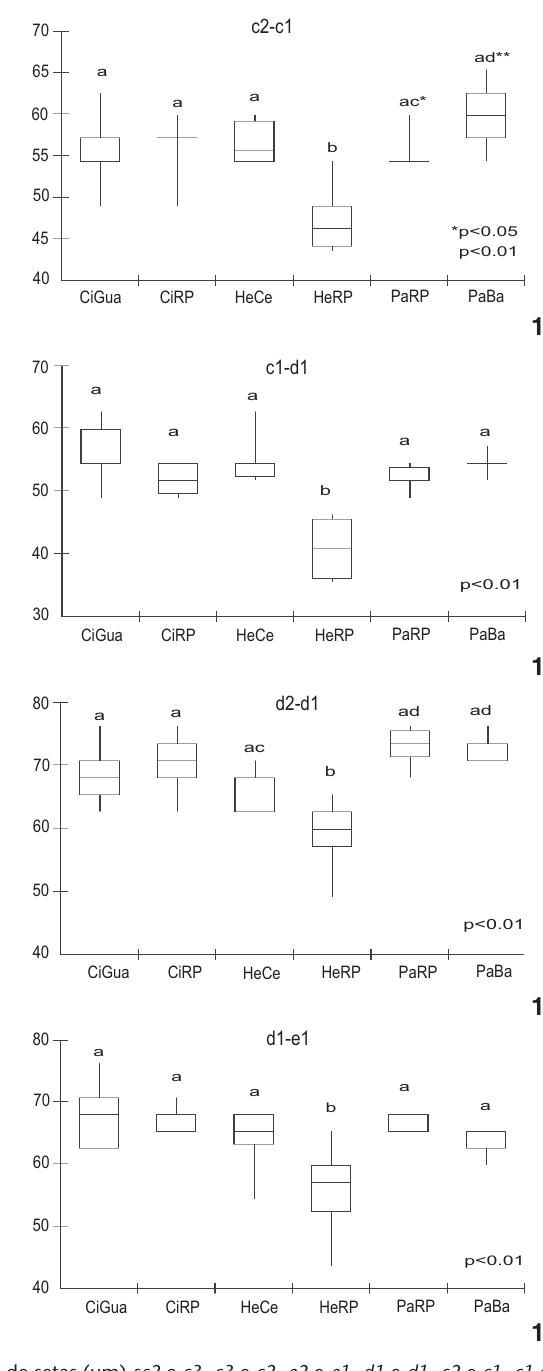
Figuras 9-16. Distribuição das distâncias entre os elementos dos pares de setas (µm) sc2 e c3 , c3 e c2 , e2 e e1 , d1 e d1 , c2 e c1 , c1 e d 1